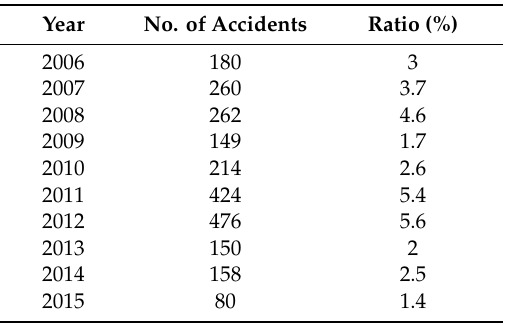
Table 2. The number of annual electrical equipment accidents caused by wind damage, heavy snowfall, cold wave, and